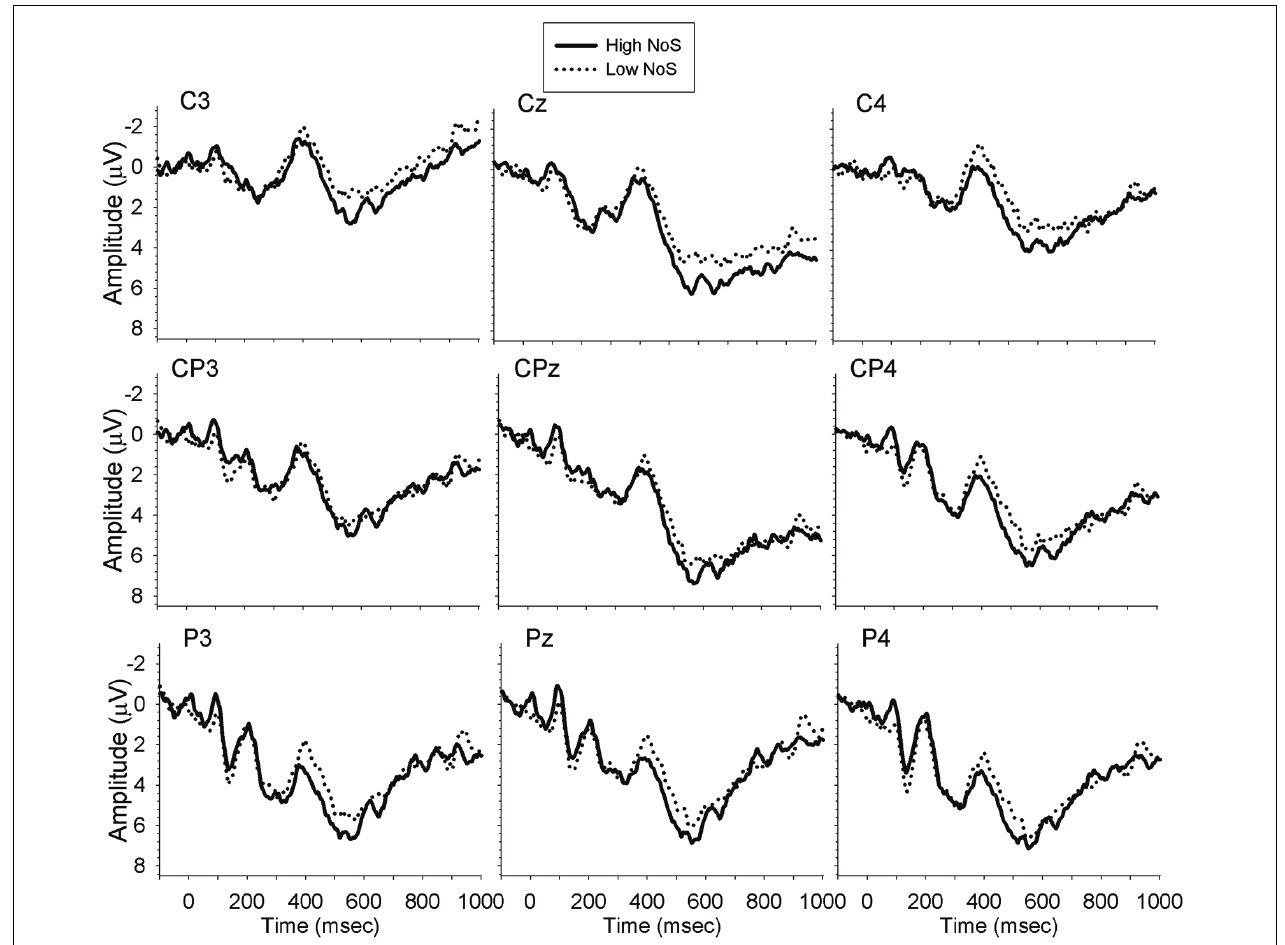
FIGURE 5 | Waveforms elicited by bilinguals performing the task in their L2.